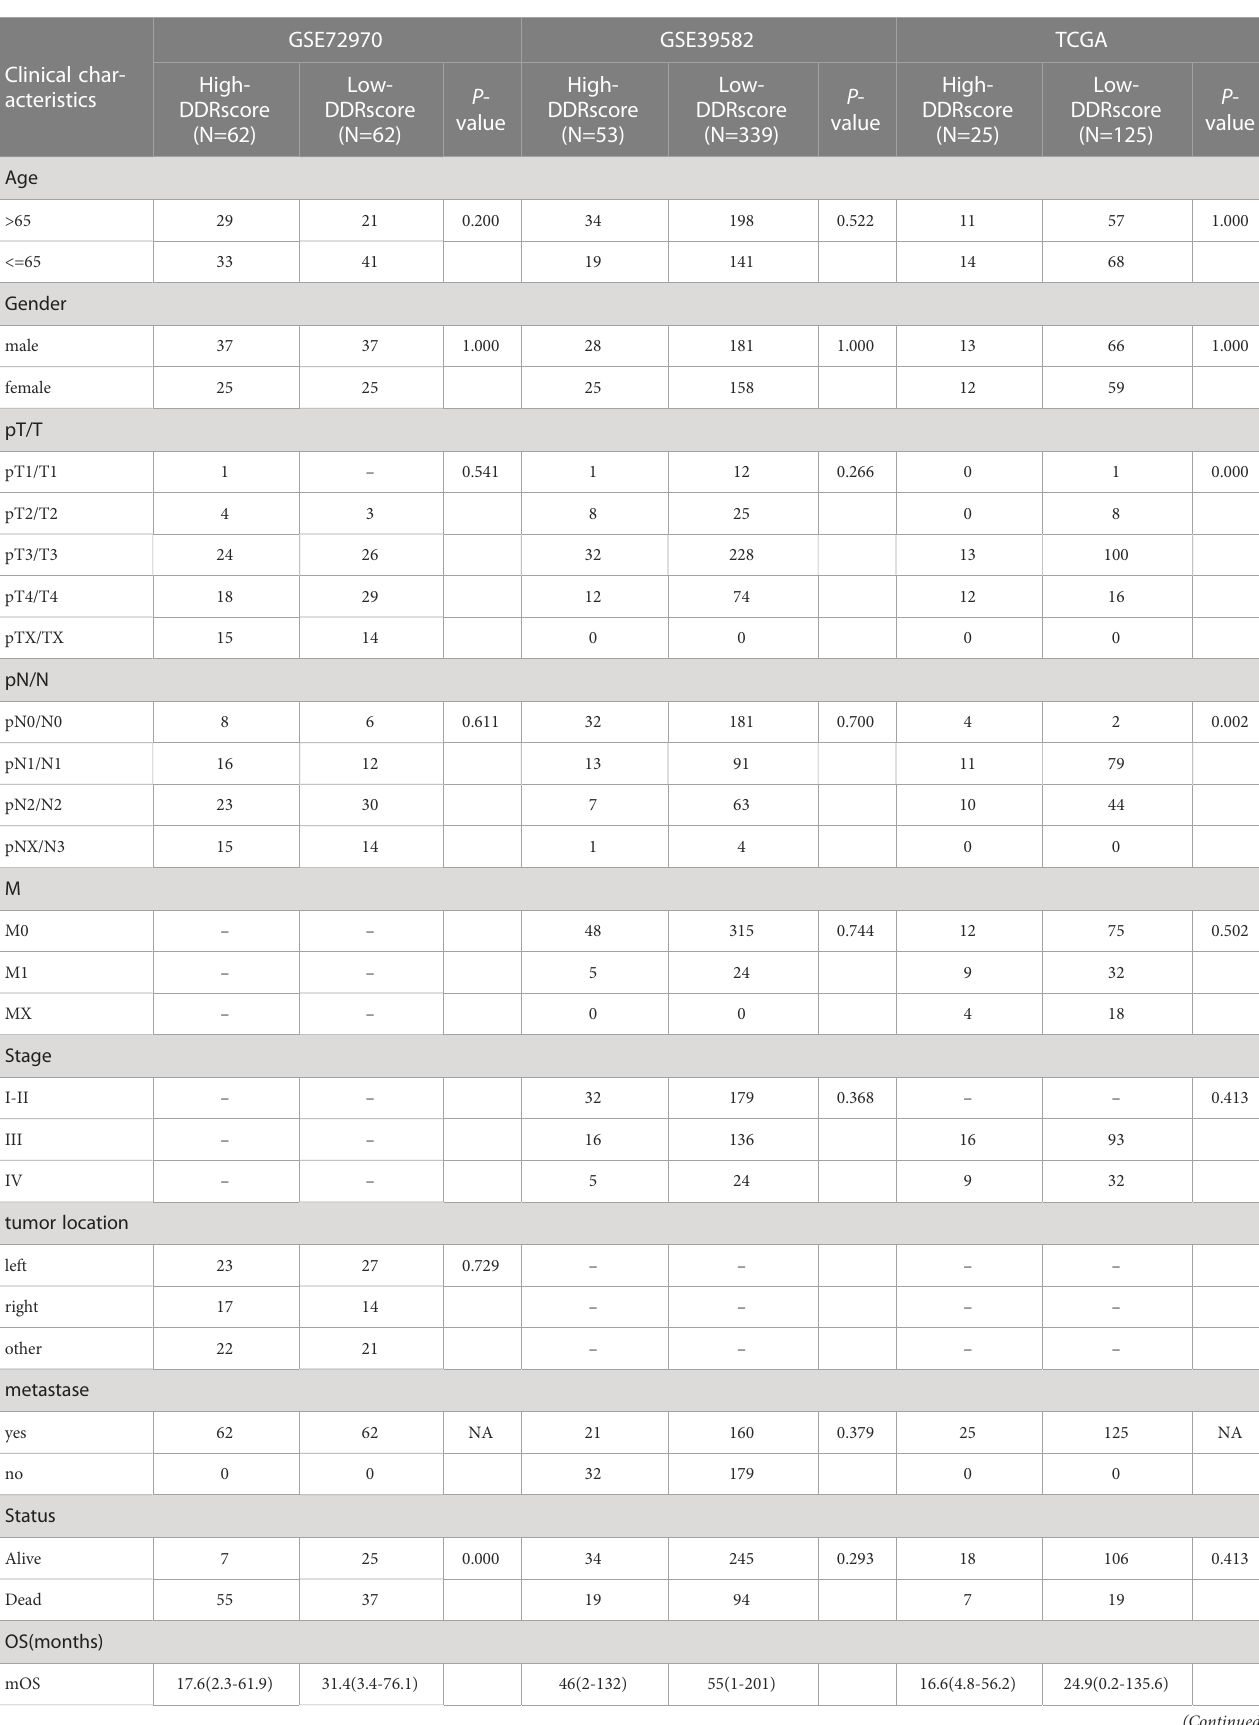
TABLE 1 Characteristics of the colorectal carcinoma patients from training and validate datasets (GSE72970 、 GES39582 and TCGA-COAD).